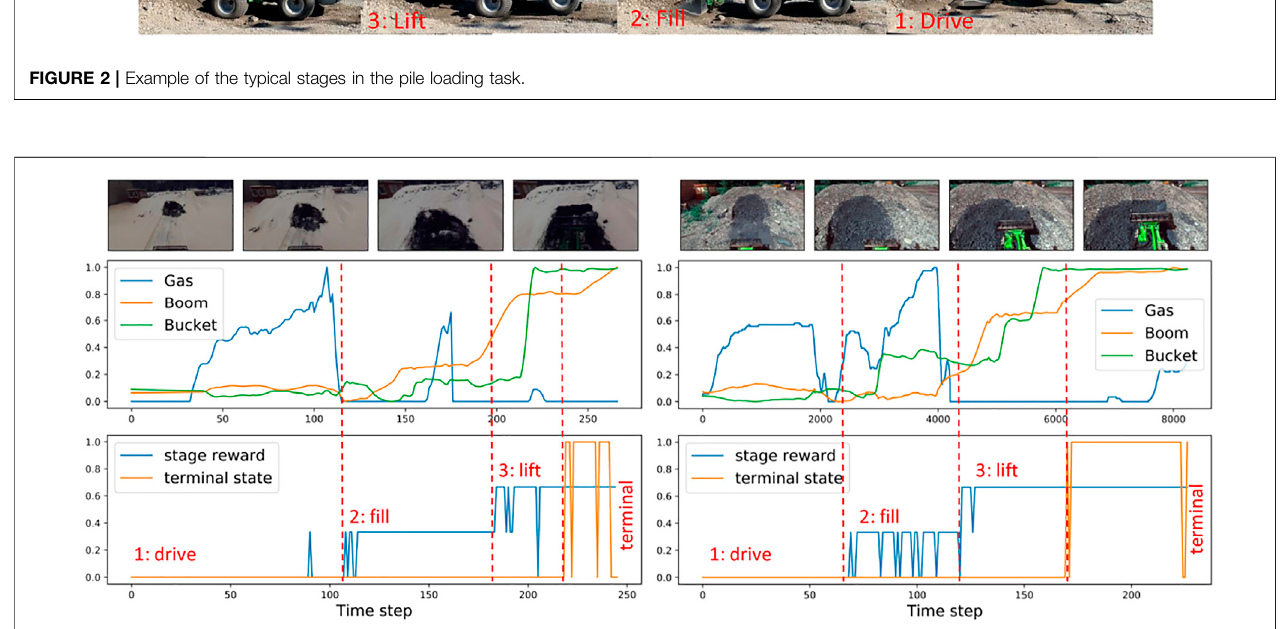
FIGURE 3 | Demonstration examples and the predicted stages: visual observation (top), corresponding to them gas commands and joint angles (middle), predicted stages of progress (bottom).